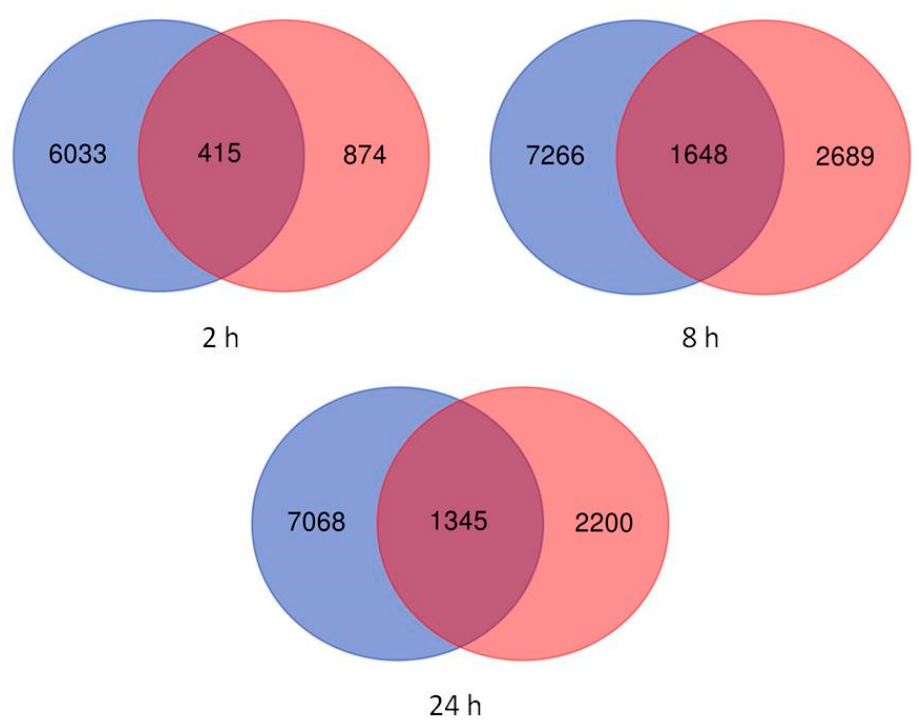
Figure 3. Shared and unique differentially expressed genes in barley seedlings. Differentially expressed genes (DEGs) exposed to 2, 8, and 24 h salt treatment were evaluated relative to untreated plants (0 h). Blue and red circles indicate roots and leaves, respectively, and shared DEGs are indicated by overlap. The number of affected genes is given for each segment of the Venn diagram.